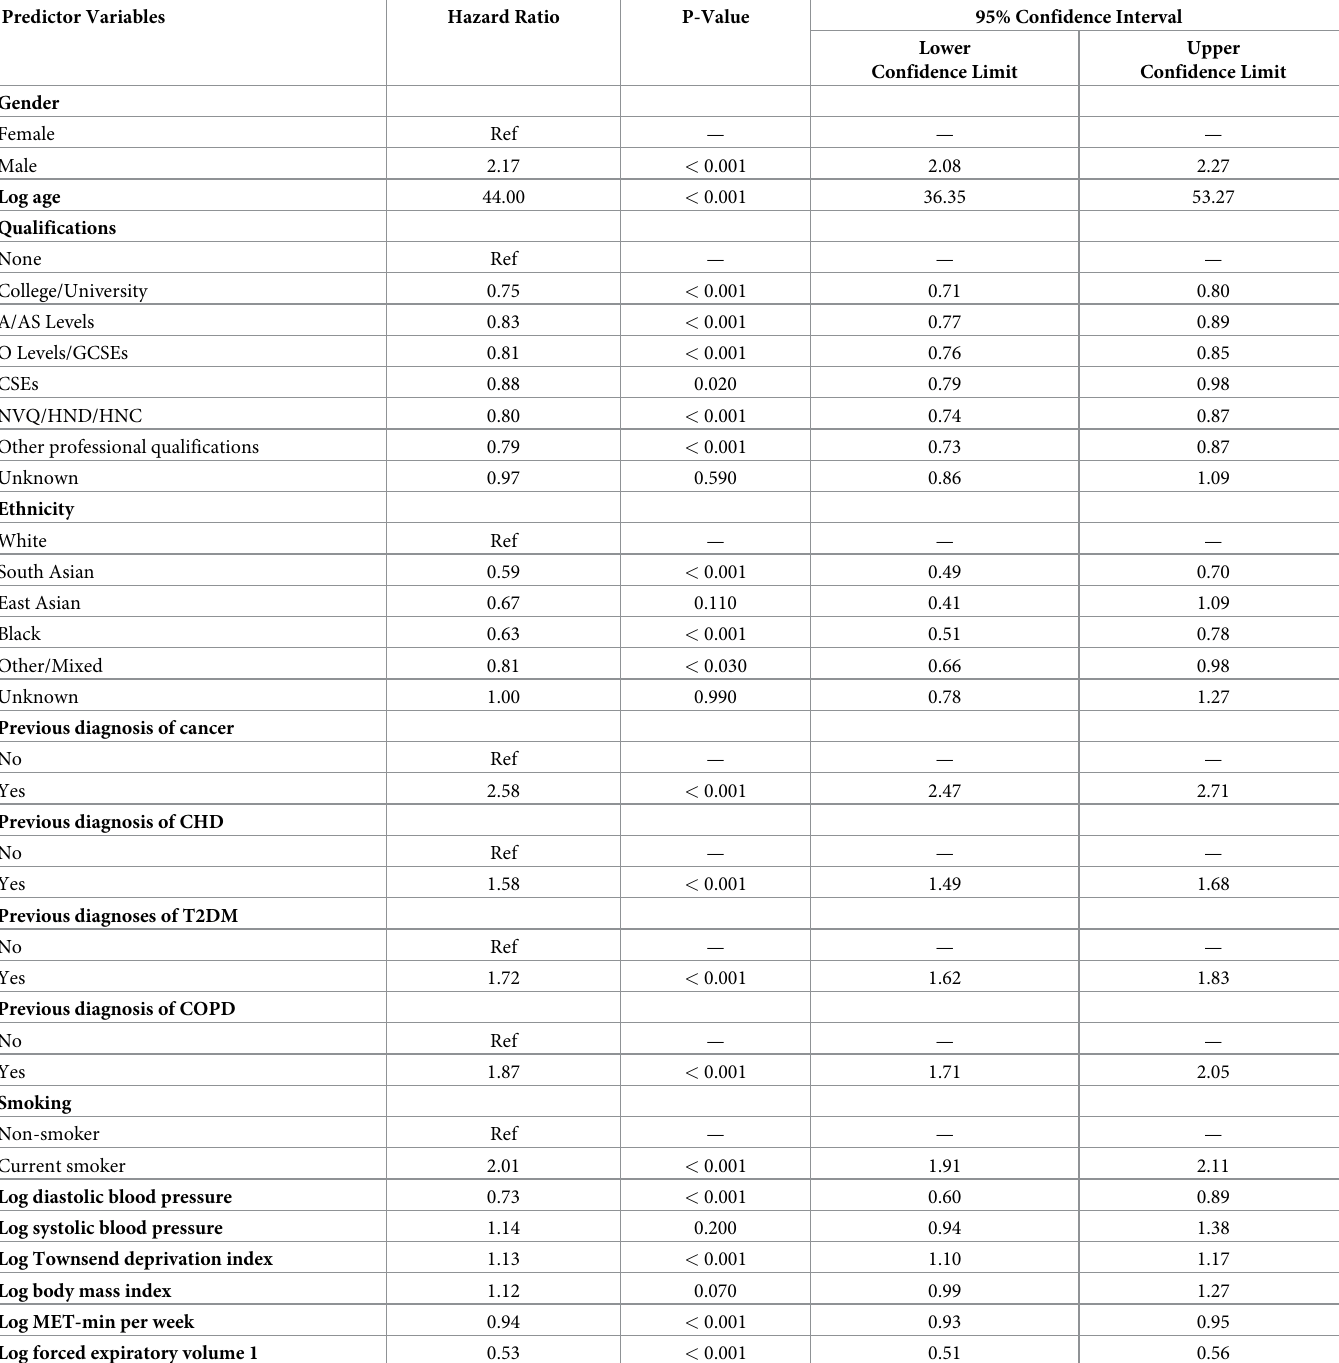
Table 2. Adjusted hazard ratios from final multivariable Cox regression model predicting 10-year mortality in the training cohort (n = 376,971). Predictor